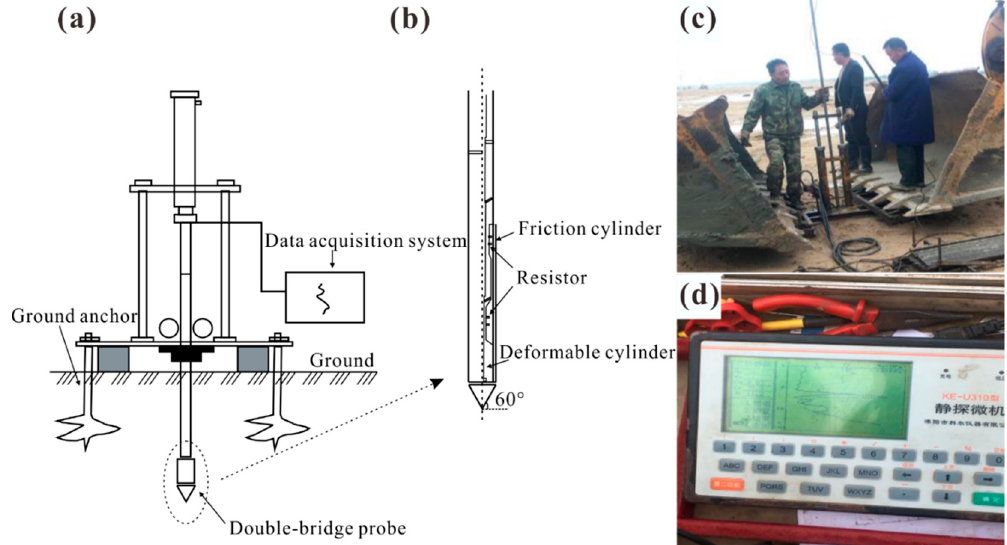
Figure 3. ( a ) Schematic of static cone penetration test: ( b ) Schematic of double bridge probe; ( c ) Reaction system; ( d ) Data acquisition system.